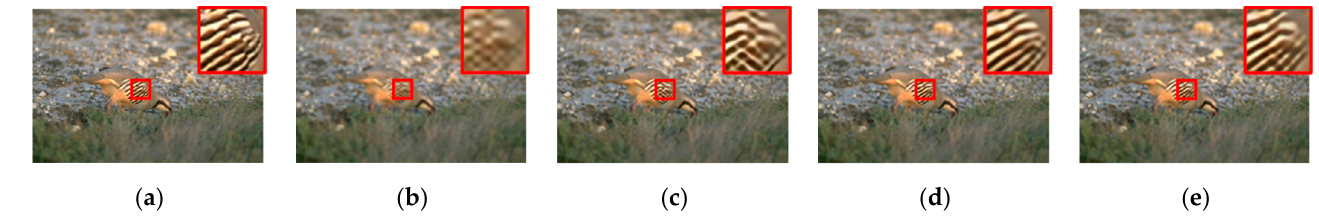
Figure 16. Visual evaluation for a scale factor of 4× on the image “8023” from B100: ( a ) Ground Truth (PSNR, SSIM); ( b ) Bicubic (30.70, 0.7447); ( c ) VDSR (34.28, 0.8699); ( d ) EDSR (35.85, 0.8832); ( e ) Proposed (35.91, 0.8851) .